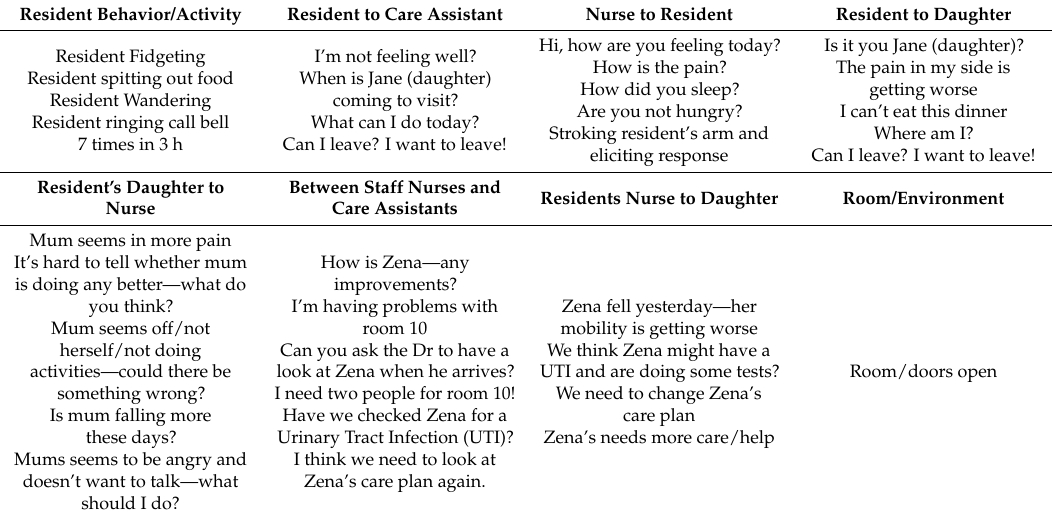
Table A4. Examples of Wellness Communication.